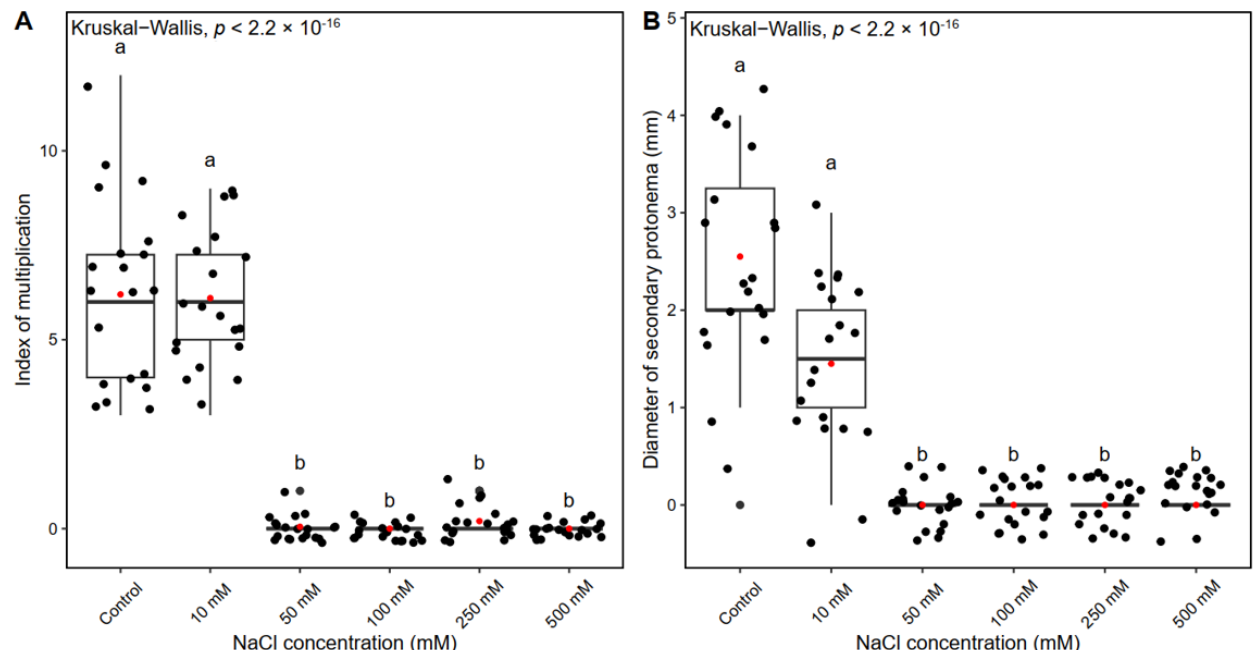
Figure 5. The index of multiplication ( A ) and secondary protonemal patch diameter ( B ) of Ptery- goneurum sibiricum on KNOP nutrient media supplemented with different NaCl concentrations in Experiment type III. The box ranges from the first (Q1) to the third (Q3) quartile, with the black horizontal line representing the median. The black dots represent individual observations, while the red dots represent the mean. The whiskers extend to the 1.5 × IQR (interquartile range) from the edge of the box. The letters above the boxplots indicate statistically significant differences among the experimental groups ( p < 0.05 after Dunn’s multiple comparisons test).